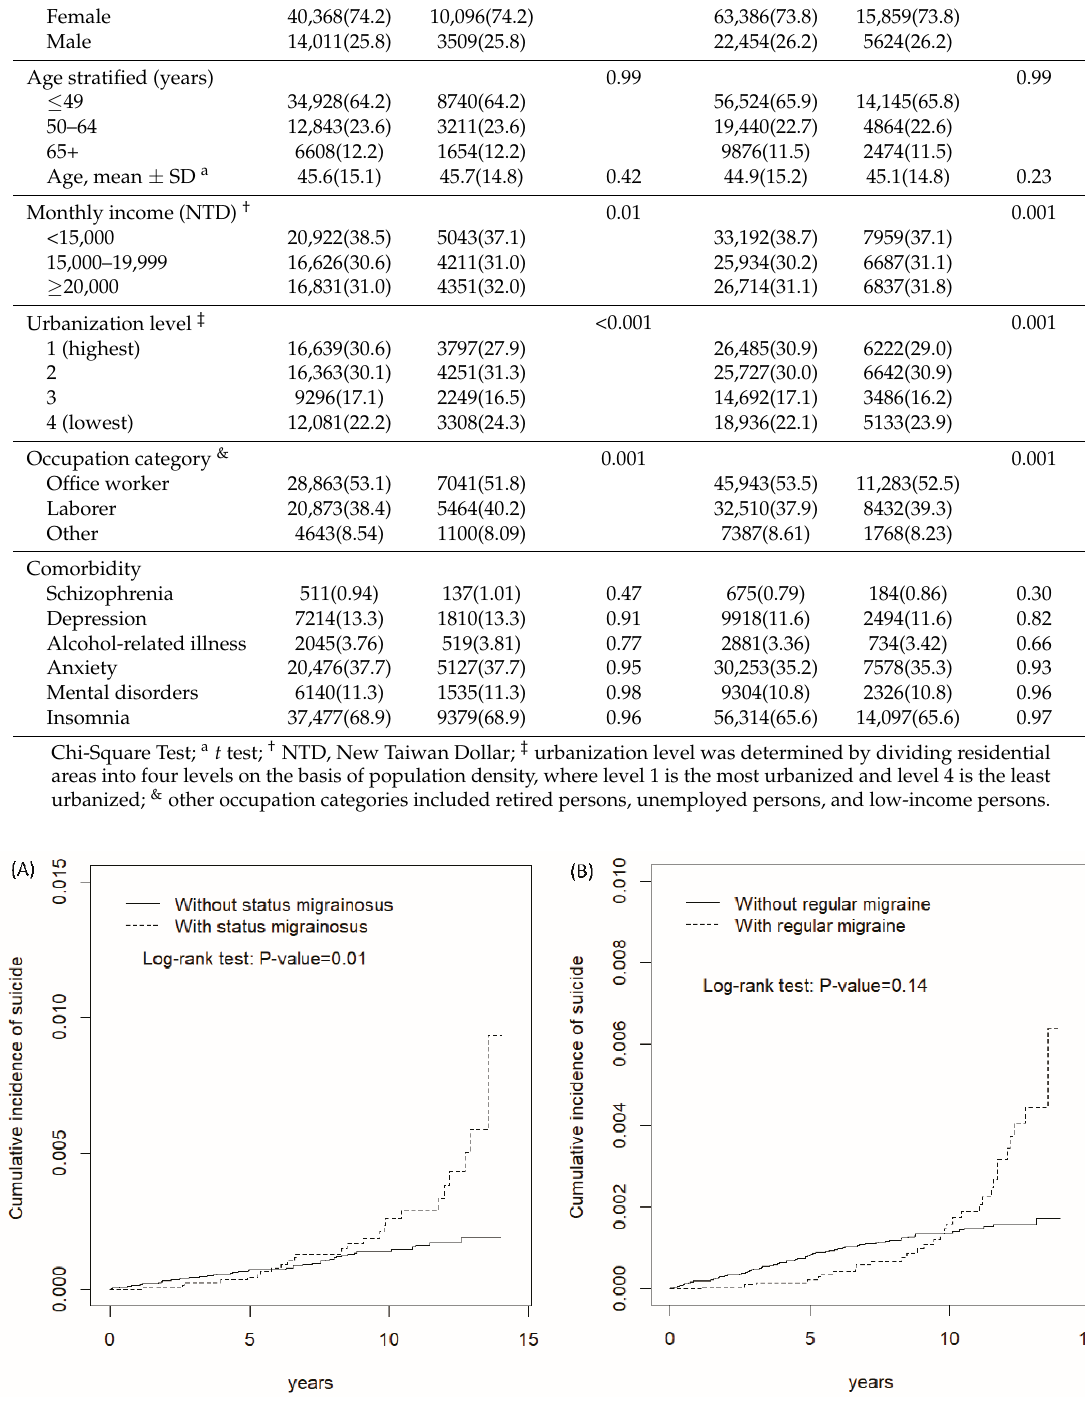
Figure 1. Cumulative incidences of suicide attempts for patients with status migrainosus and the comparison cohort ( A ), and for patients with regular migraines and the comparison cohort ( B ).